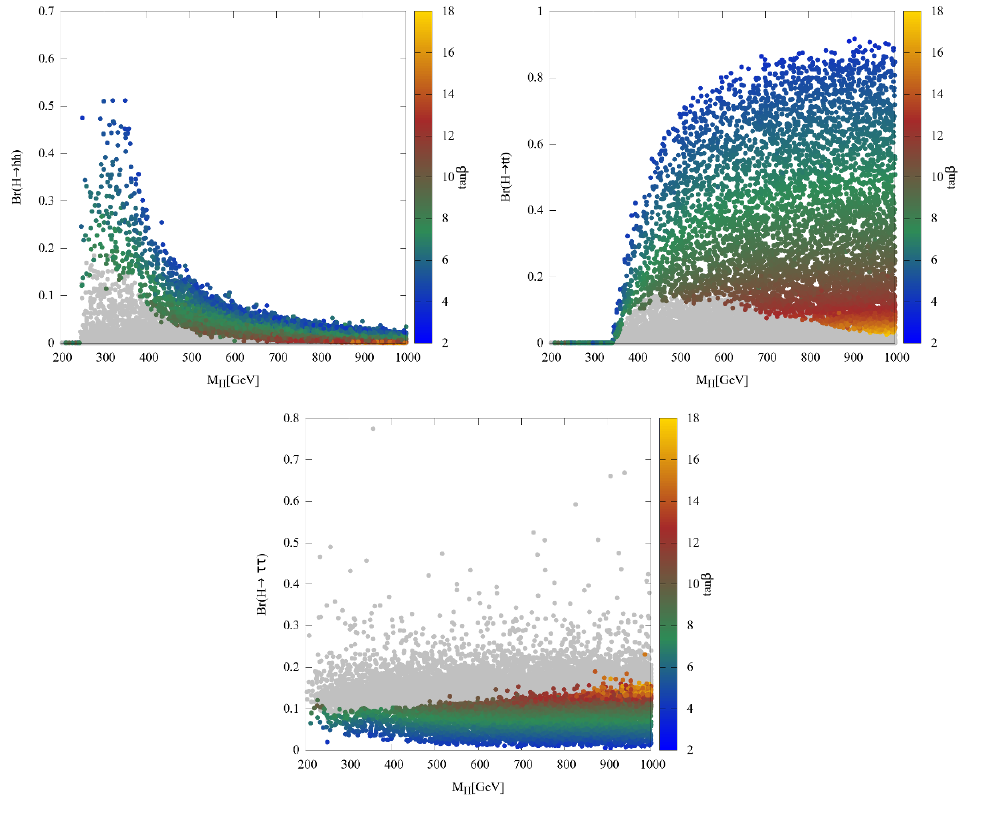
Figure 39 . Branching ratios of H points are allowed by the SM-like Higgs mass and Higgs signal strength constraints. The grey points are excluded by the present direct searches for the heavy Higgs